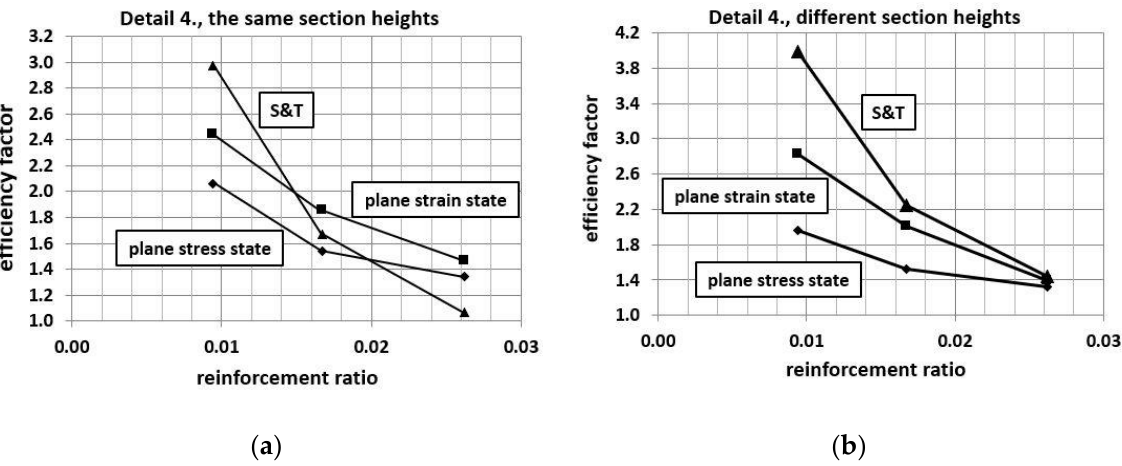
Figure 27. Corner efficiency factor vs. reinforcement ratio — detail No. 4, ( a ) the same section heights, ( b ) different section heights.